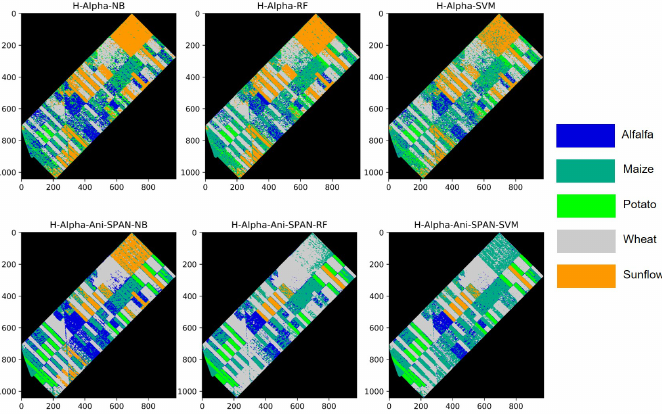
Figure 4. Spatial distribution of training and testing data